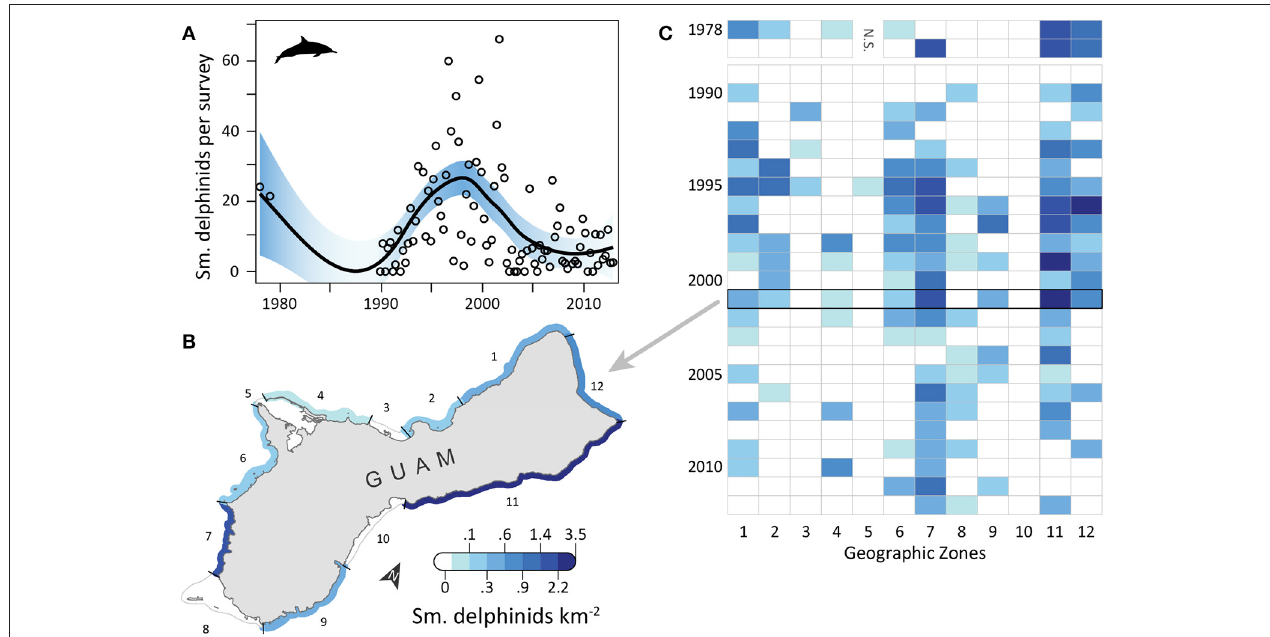
FIGURE 4 | Fluctuating trend in small delphinid observations around Guam since 1978. (A) Trend in small delphinid observations from semimonthly aerial surveys conducted by Guam Division of Aquatic and Wildlife Resources (DAWR). Open circles are observations (small delphinids) per survey (OPS) by year or quarter. Model fit with shaded 95% confidence interval shows that observations were highly variable over the time series. Correspondingly, mean observation growth rate (OGR) was negative in 1978–1989 (mean = − 0.22, SD = 0.06, CV = 28%) and 1999–2009 (mean = − 0.15, SD = 0.07, CV = 44%) and positive in 1990–1998 (mean = 0.35, SD = 0.30, CV = 87%) and 2010–2012 (mean = 0.06, SD = 0.03, CV = 52%). (B) Map of observed densities for 2001, the year with the highest annual OPS. Density was highest in zone 11 and lowest in zones 3, 5, 8, and 10. (C) The highest, most widespread positive densities were observed throughout the 1990s and early 2000s. Densities decreased over time in zones 1, 2, 6, 11, and 12. Observations were rare in zones 3–5, and never occurred in zone 10. Military restrictions prohibited surveys in zone 5 in